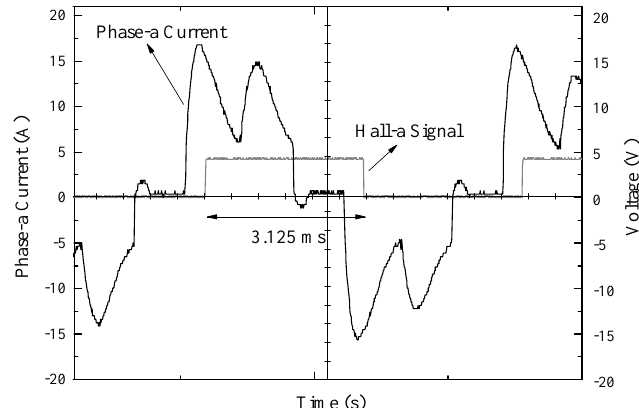
Figure 17. Phase– a current and hall– a signal under 7 N · m load with 25 ◦ reference delay